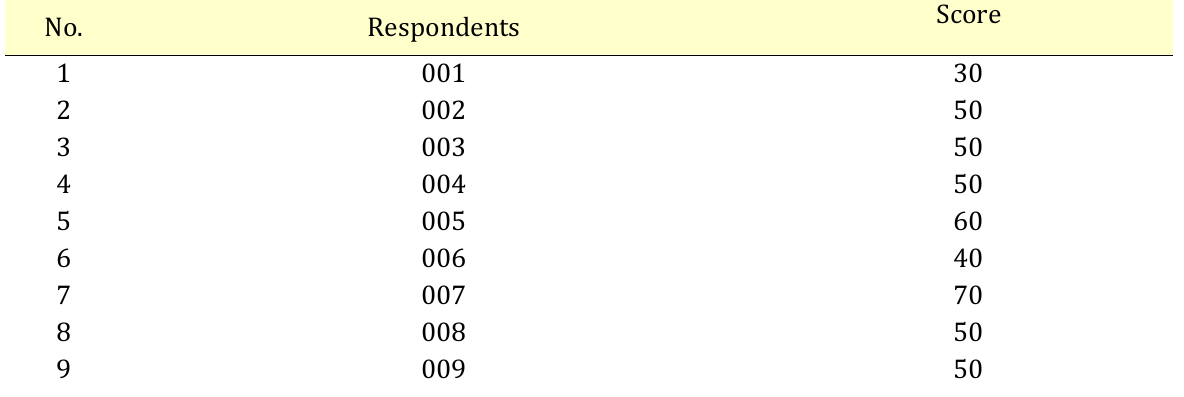
Table 1. The result of the test in cycle